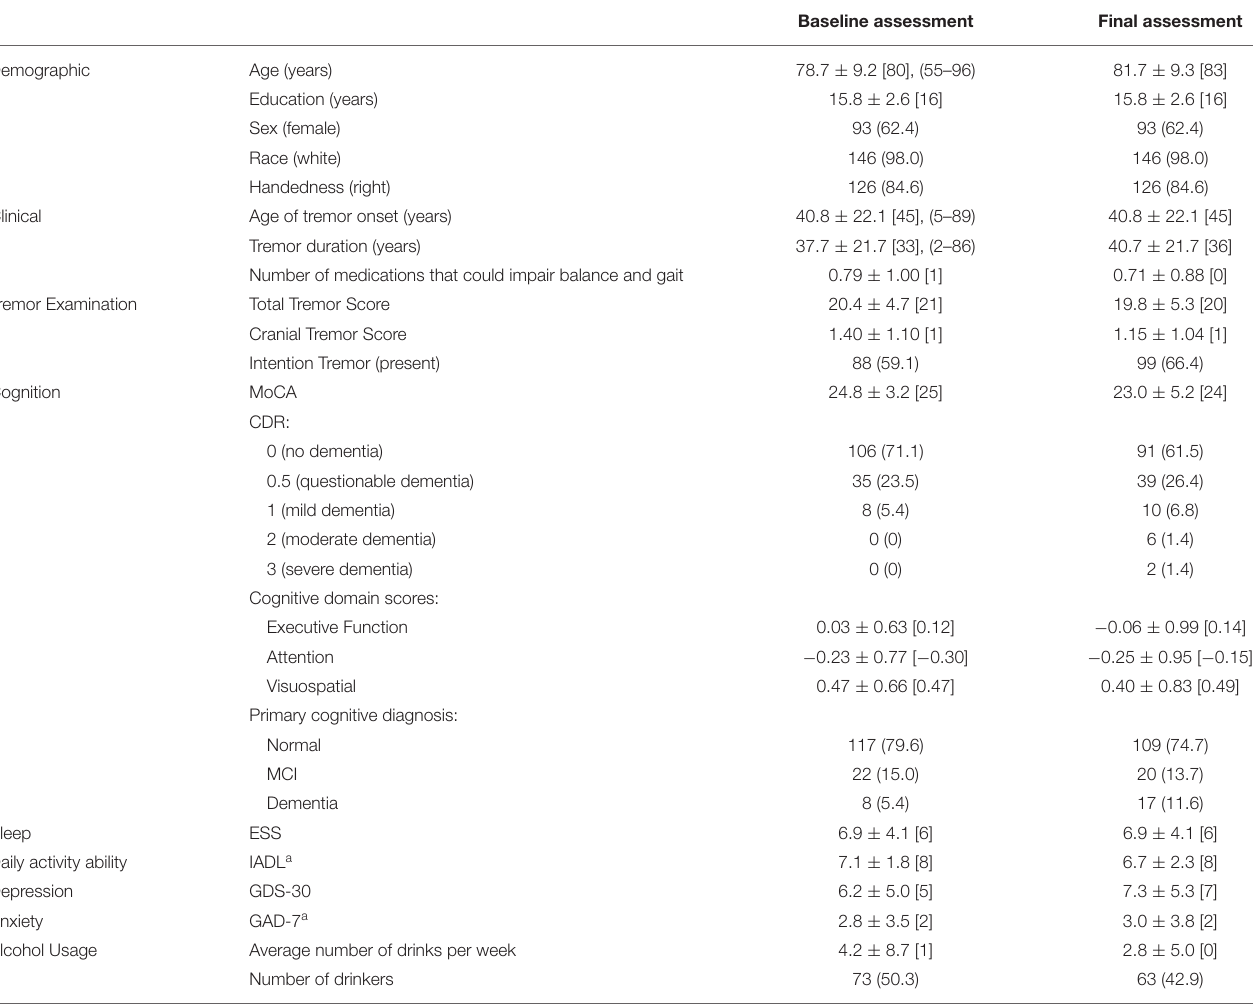
TABLE 1 | Demographic and clinical characteristics of 149 ET